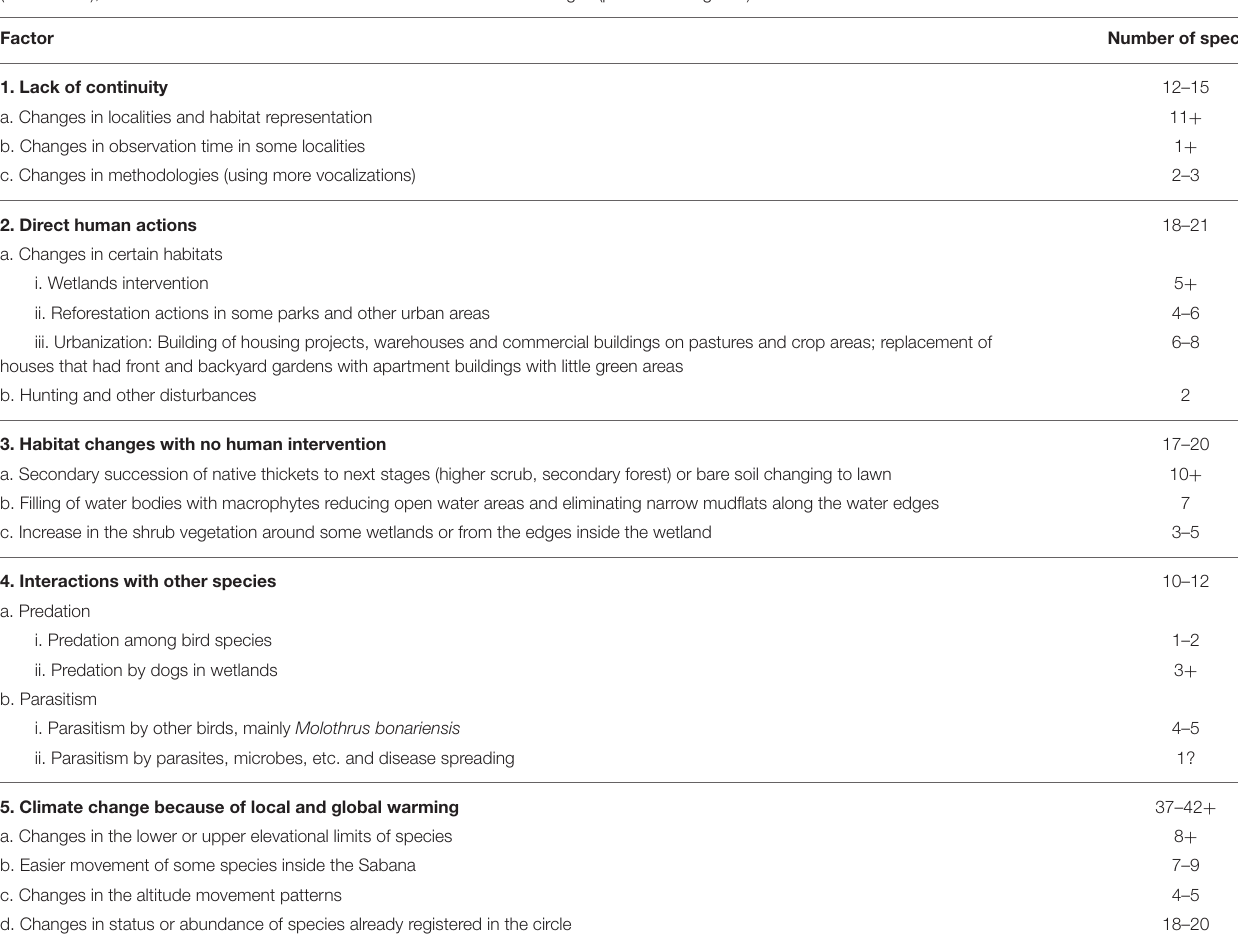
TABLE 6 | Number of species with changes in status or abundance recorded in the Audubon’s Christmas Bird Counts of the Sabana of Bogotá over 26 years (1989–2014), for each of the five factors that could have caused these changes (positive or